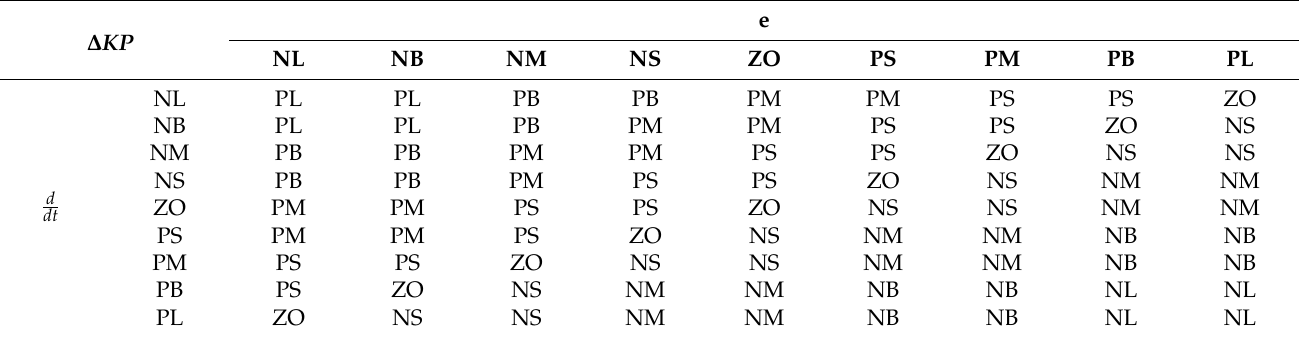
Table 2. Fuzzy control rules.